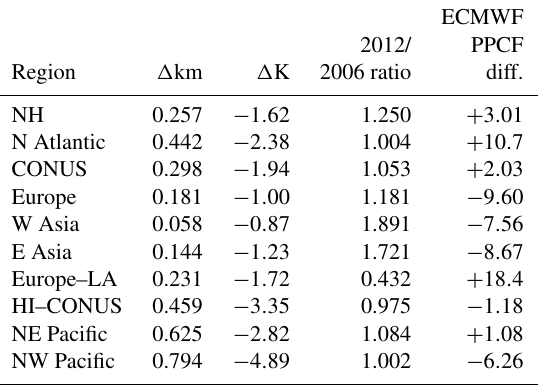
Table 2. Changes (2012–2006) in annual-mean flight altitude (in km), annual-mean flight temperature (in K), and the ratio of annual- mean air traffic density between 2012 and 2006 for NH and nine air traffic regions based on a 12d sample (15th of each month) of way- point data from both years. Relative changes (%) in annual-mean potential persistent contrail frequency (PPCF) between 2012 and 2006 for NH and nine air traffic regions are based on ECMWF re- analysis